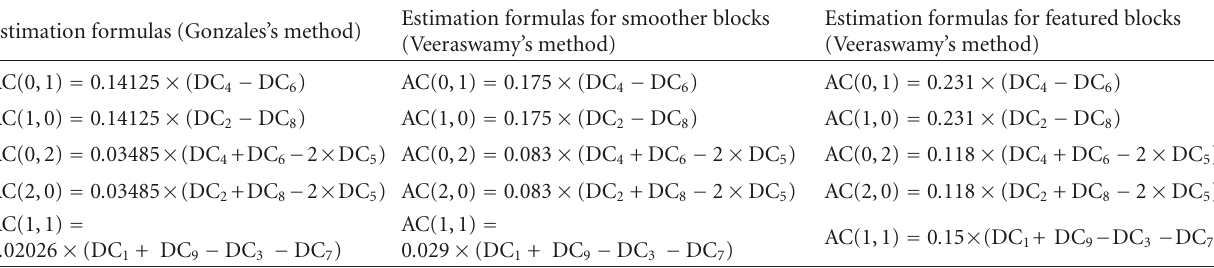
Table 1: The formulas to estimate the first five AC coe ffi cients of each 4 × 4 DCT block (1).